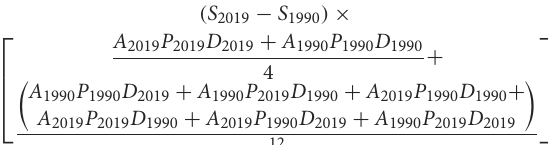
posterior distribution and bases on the ordinal 2.5th and 97.5th draws of uncertainty